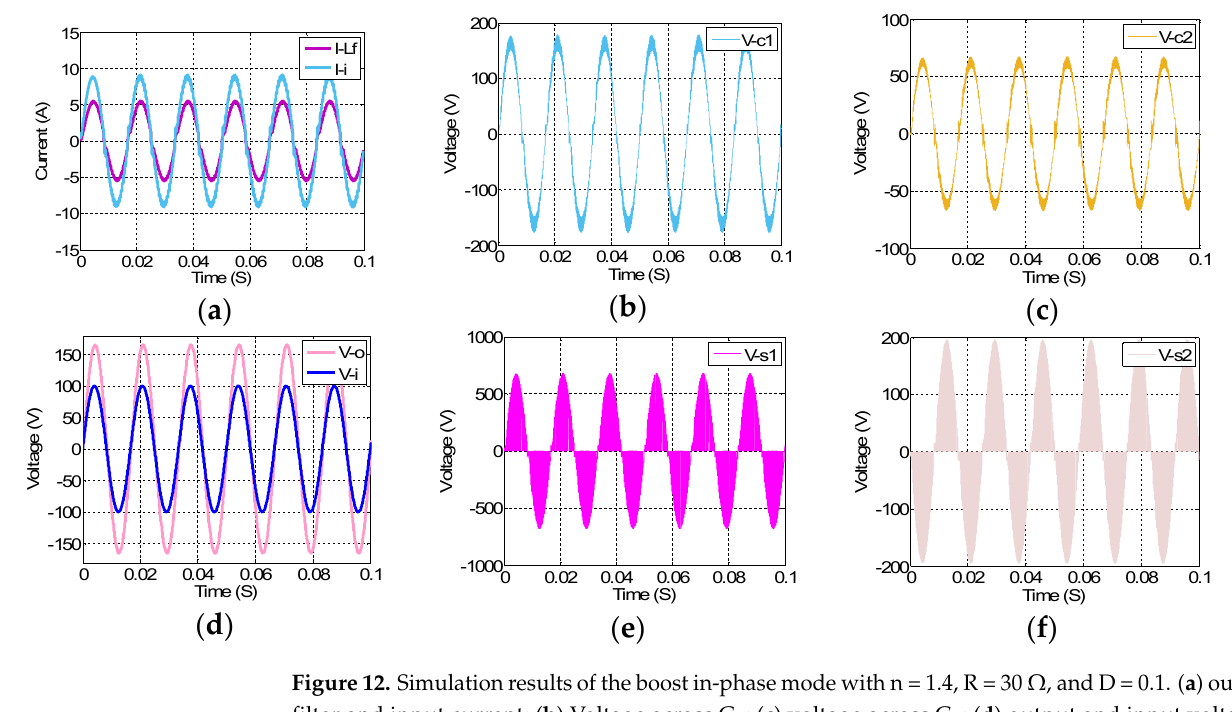
Figure 12. Simulation results of the boost in-phase mode with n = 1.4, R = 30 Ω, and D = 0.1. ( a ) output filter and input current; ( b ) Voltage across C 1 ; ( c ) voltage across C 2 ; ( d ) output and input voltages; ( e ) voltage across S 1 ; ( f ) voltage across S 2.